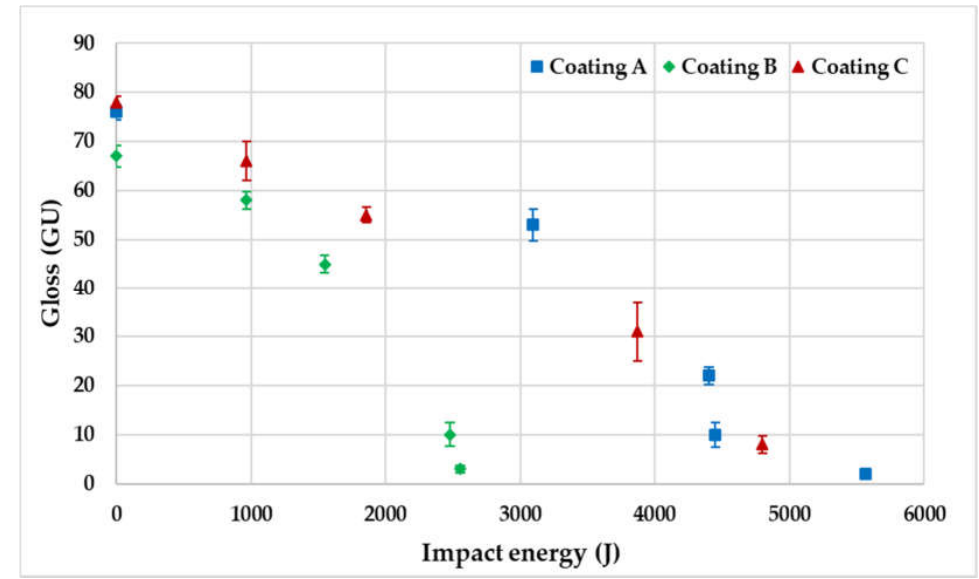
Figure 13. Coating surface gloss at impact energy for coatings A, B, and C.